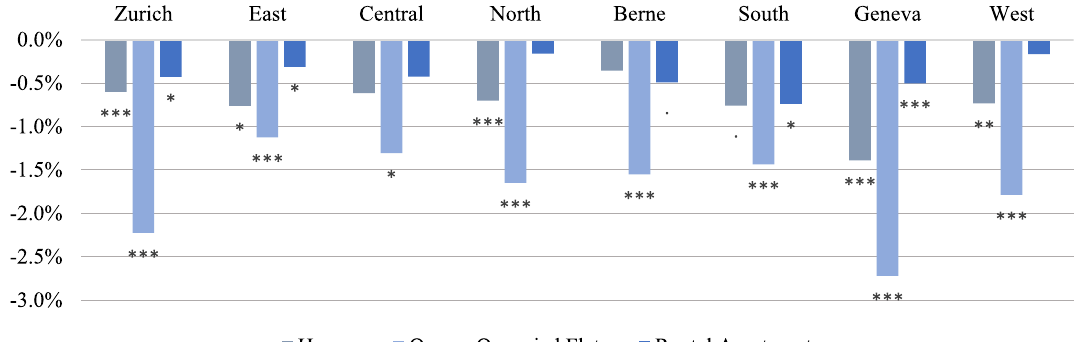
Fig. 8 Residential housing—interest rate effect across Swiss monitoring. Notes : Displayed coefficients correspond to yields on governmental bonds with 10-year maturity for each monitoring region in Switzerland. The coefficients are the results of a fixed-effect panel regression capturing 106 Swiss MS-regions between 2005 Q1 and 2018 Q4 (56 quarters) analogous to the baseline regression model in Table 2 model 1. Signif. codes: “***” 0.001, “**” 0.01, “*” 0.05, “.”